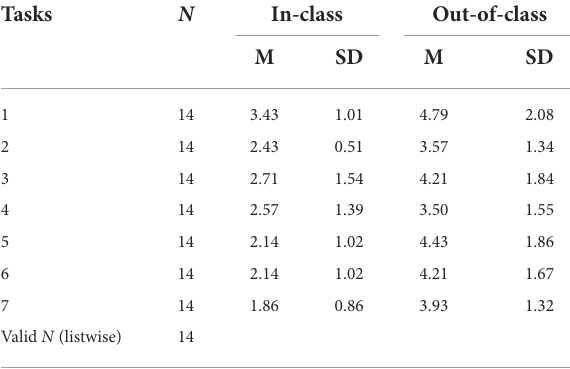
TABLE 3 The most effective flipped classroom model for